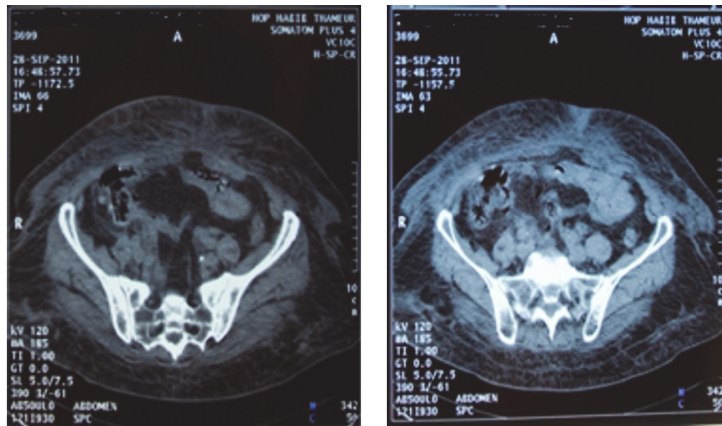
Figure 1: Extensive hematoma of jejunum associated with mild pelvic fluid.